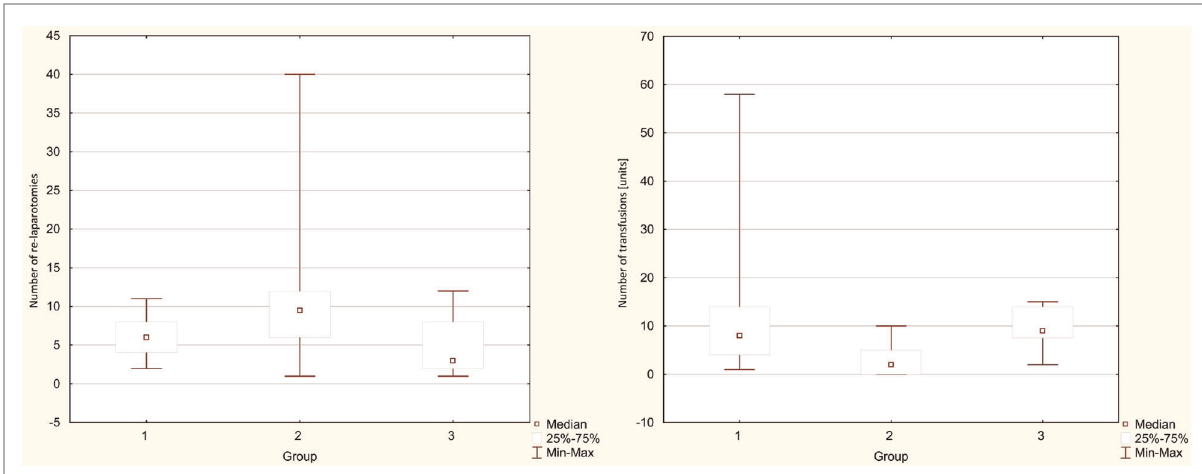
FIGURE 2 Boxplots comparing the individual monitored parameters between the groups. Group 1: PJA disconnection group; Group 2: Simple drainage group; Group 3: Total pancreatectomy group.